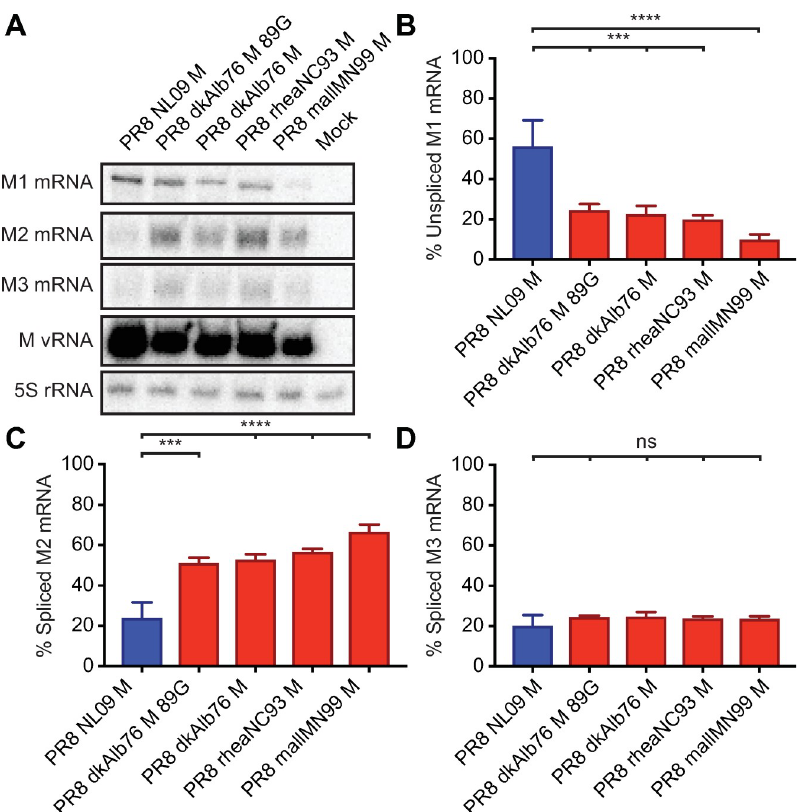
Fig 7. Ratio of mRNA 7 (encoding M1) to mRNA 10 (encoding M2) expression in A549 cells is dependent upon viral M segment host origin. A549 cells were inoculated at a MOI of 5 PFU/cell with PR8 viruses encoding avian or human-derived M segments and incubated at 37˚C for 8 h prior to RNA extraction. RT primer extension radiogram of virus-infected A549 cells: (A) 5S rRNA levels were measured to allow normalization of viral RNA. Segment 7 vRNA expression was measured to assess viral replication. Levels of mRNA 7 , mRNA 10 , and mRNA 11 mRNA expression were assessed using radiolabeled probes. (B) mRNA 7 , (C) mRNA 10 , and (D) mRNA 11 was quantitated and displayed as a percentage of total M gene expressed mRNA. Graphs in B-D show the means with SD from three independent experiments. For each experiment, two replicate radiograms were quantitated. Statistical significance was assessed using ordinary one-way